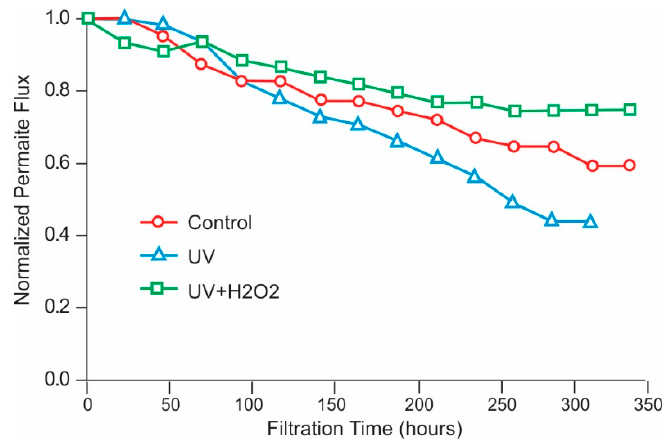
Figure 24. Normalized permeate flux as a function of operating time as a measure of biofouling control for membrane pretreated with MP-UV/hydrogen peroxide, UV only, and no bio-control method. [385]. Reproduced by permission of The Royal Society of Chemistry.